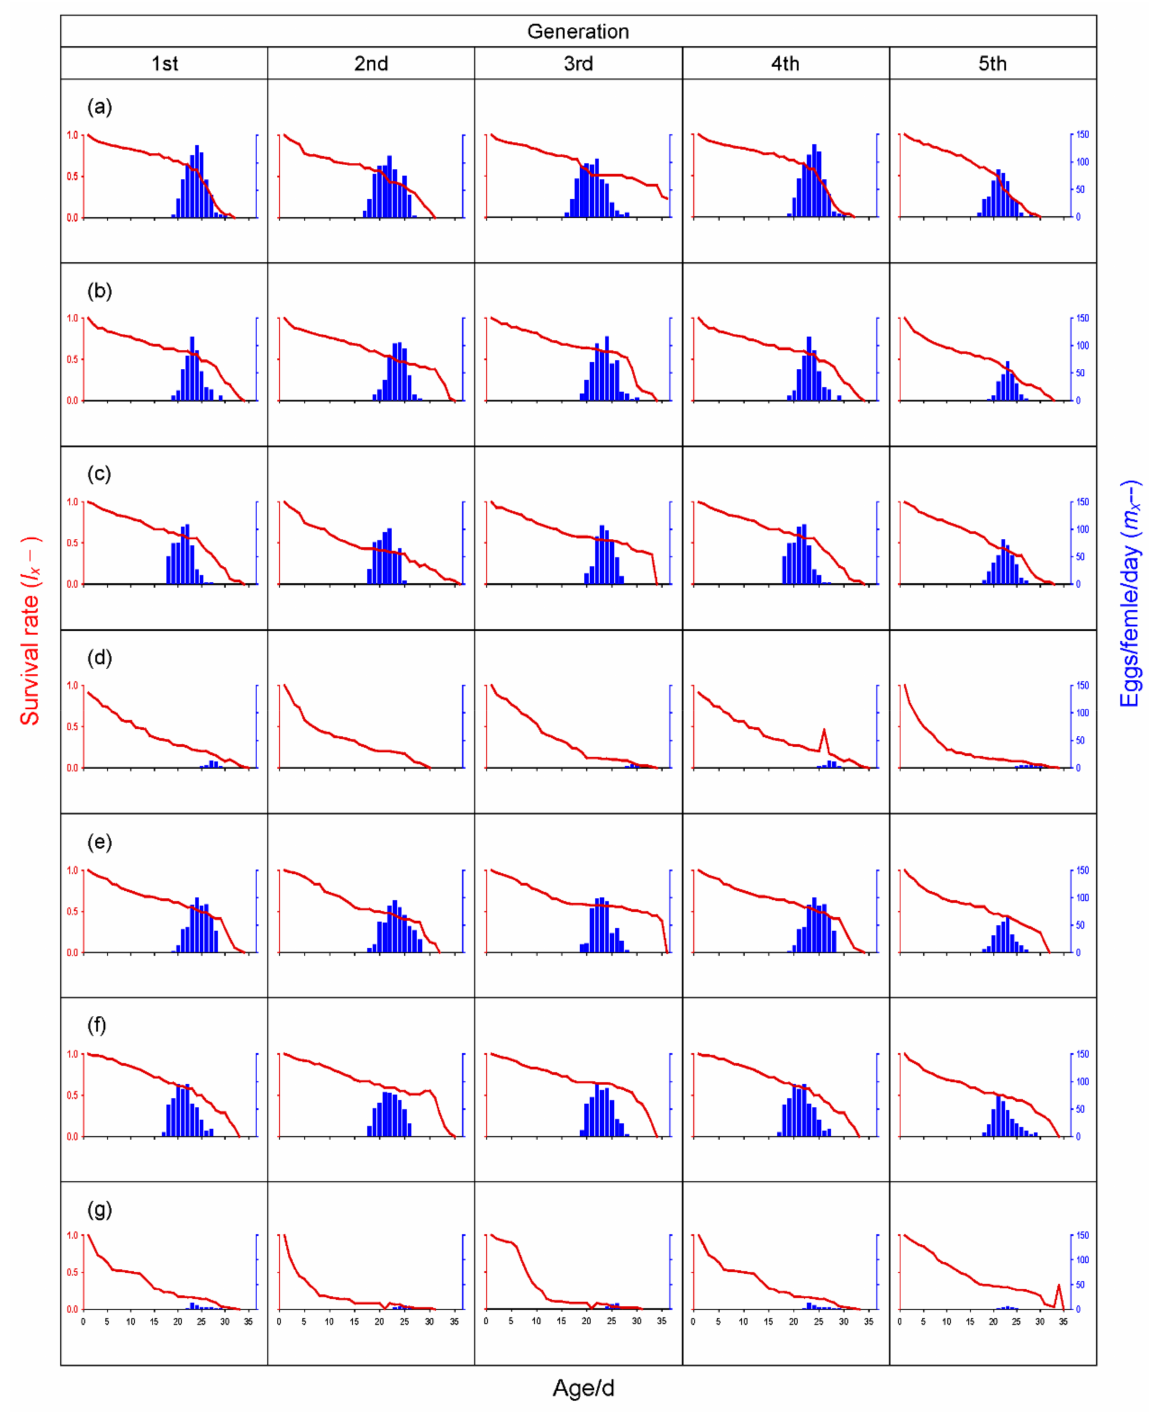
Figure 3. Fecundity ( m x – ) and survival rate ( l x – ) of Nilaparvata lugens on different rice varieties in different rearing arrangements at 28 ◦ C. ( a ) TN1/TN1; ( b ) Mudgo/Mudgo; ( c ) ADS7/ASD7; ( d ) Rathu Heenati/Rathu Heenati; ( e ) Mudgo/TN1; ( f ) ADS7/TN1; ( g ) Rathu Heenati/TN1. The “high-dose/refuge (HDR)” strategy has been widely adopted to delay the evo- lution of pest virulence to Bt crops—as long as there are non-Bt crops as “refuges”, the validity period of Bt crops will be extended [35,36]. In the present study, our results of alternating resistant varieties (Mudgo, ASD7, and Rathu Heenati) with the susceptible variety TN1 to rear multiple generations of a BPH colony showed that feeding